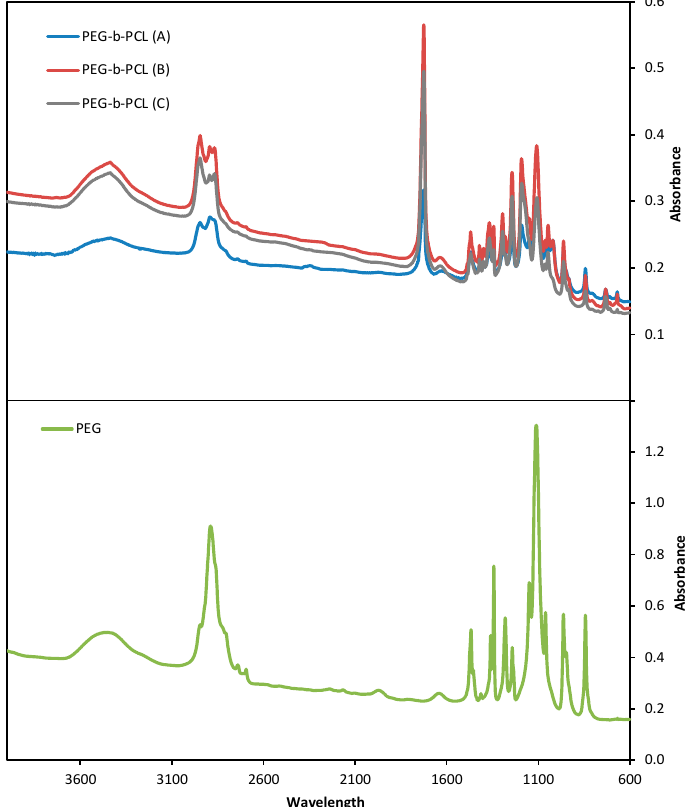
Figure 3. Fourier Transformed Infrared Spectroscopy (FTIR) spectra for Poly(ethylene glycol) (PEG) and the synthesized Poly(ethylene glycol)-b-poly( ε -caprolactone)